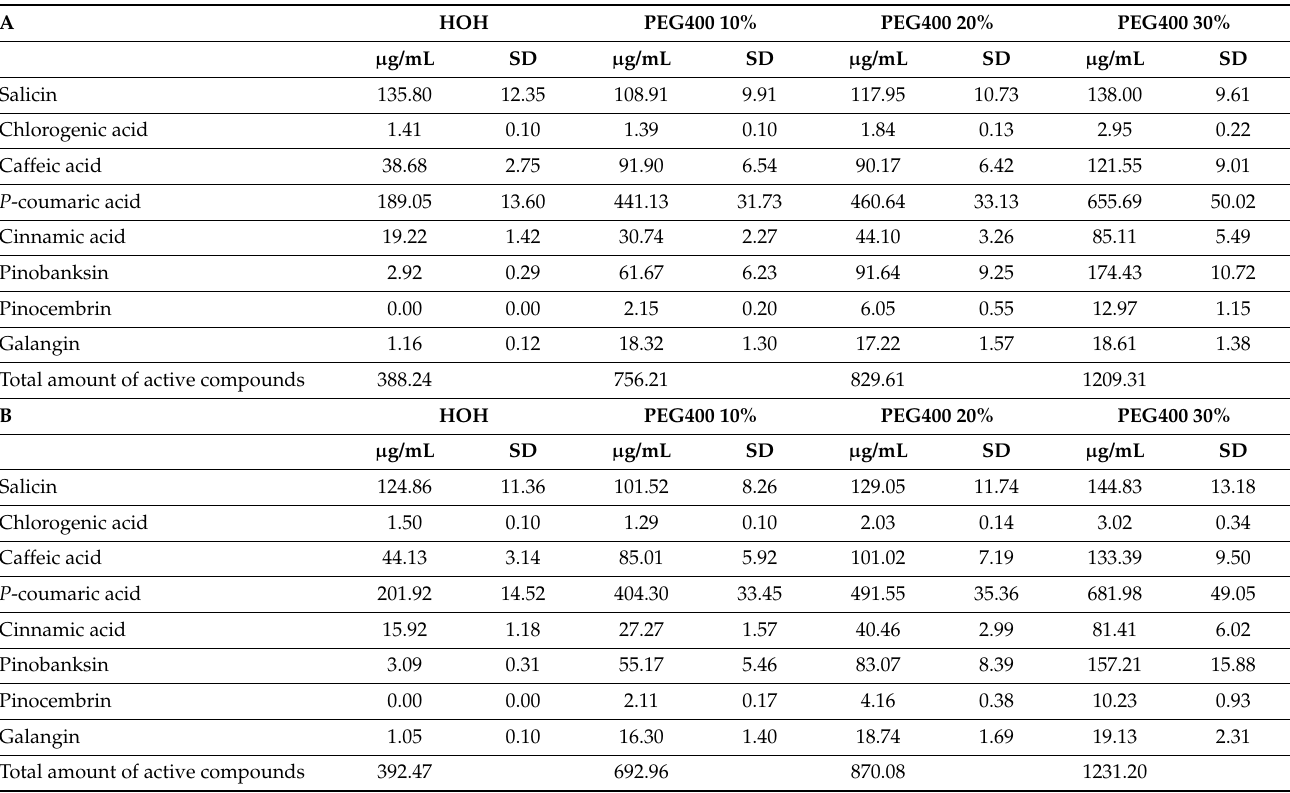
Table 1. HPLC analysis of balsam poplar buds aqueous, aqueous 10% PEG400, aqueous 20% PEG400 and aqueous 30% PEG400 extracts. A—before sterilization, B—after sterilization. The data presented as mean ( µ g/mL) and standard deviation (SD), n = 3.